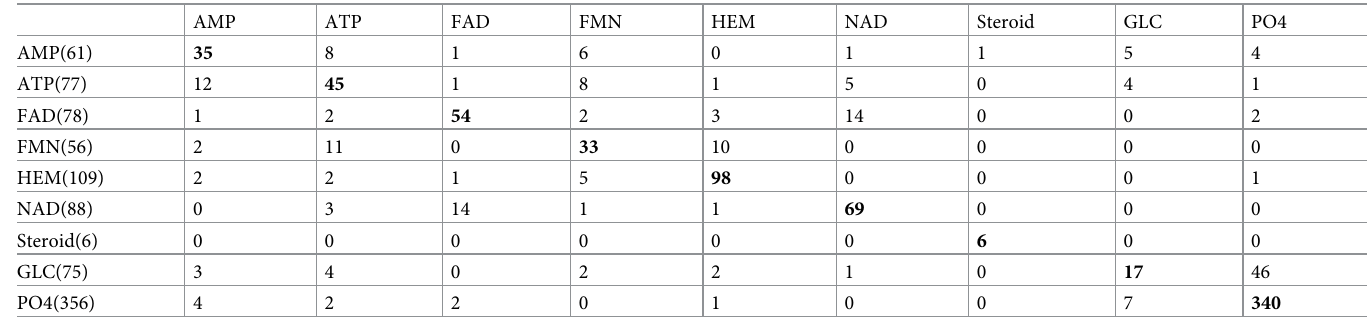
Table 8. Classification of binding sites for extended Kahraman dataset using the logistic regression classifier.